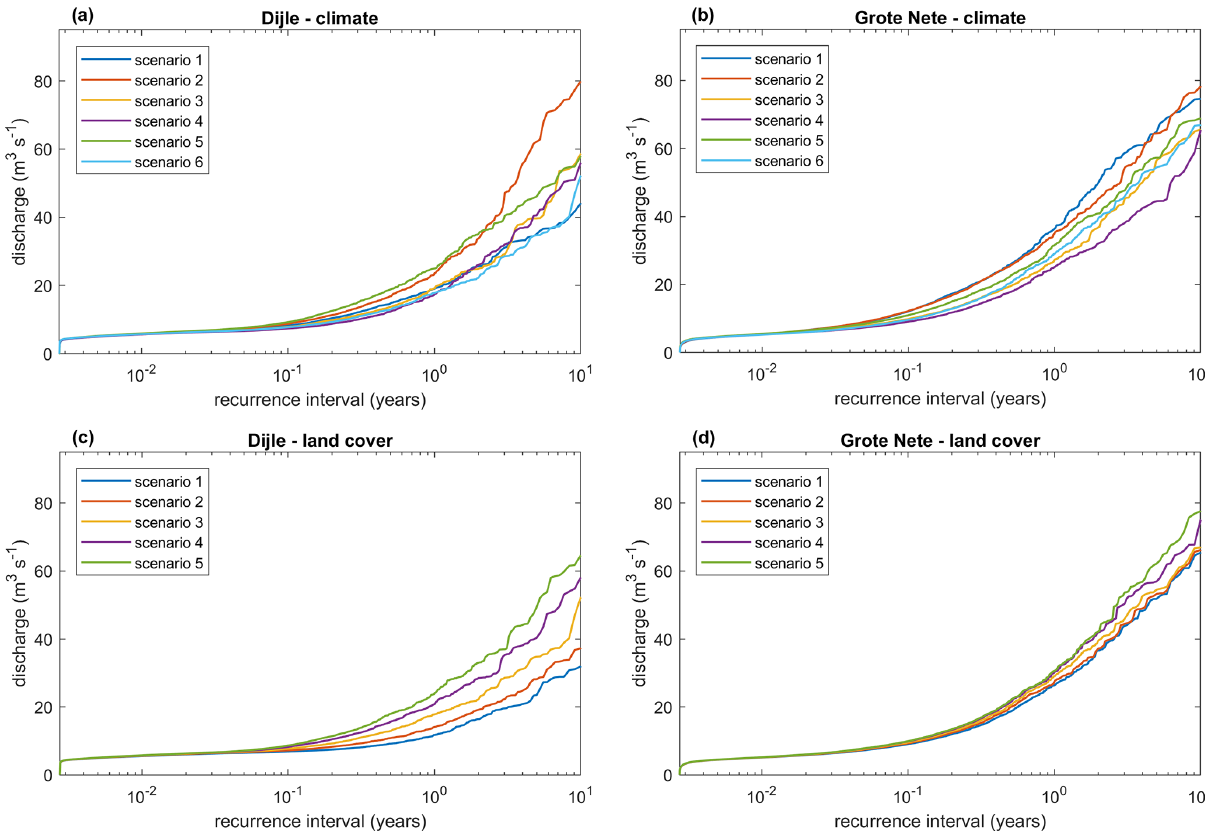
Figure A7. Recurrence intervals (years) for the simulated daily discharge (m 3 s − 1 ) for the Dijle River at Korbeek-Dijle (a, c) and the Grote Nete River at Hulshout (b, d) under the different climate scenarios for land cover scenario 3 (a, b) and land cover scenarios for climate scenario 6 (c, d) .